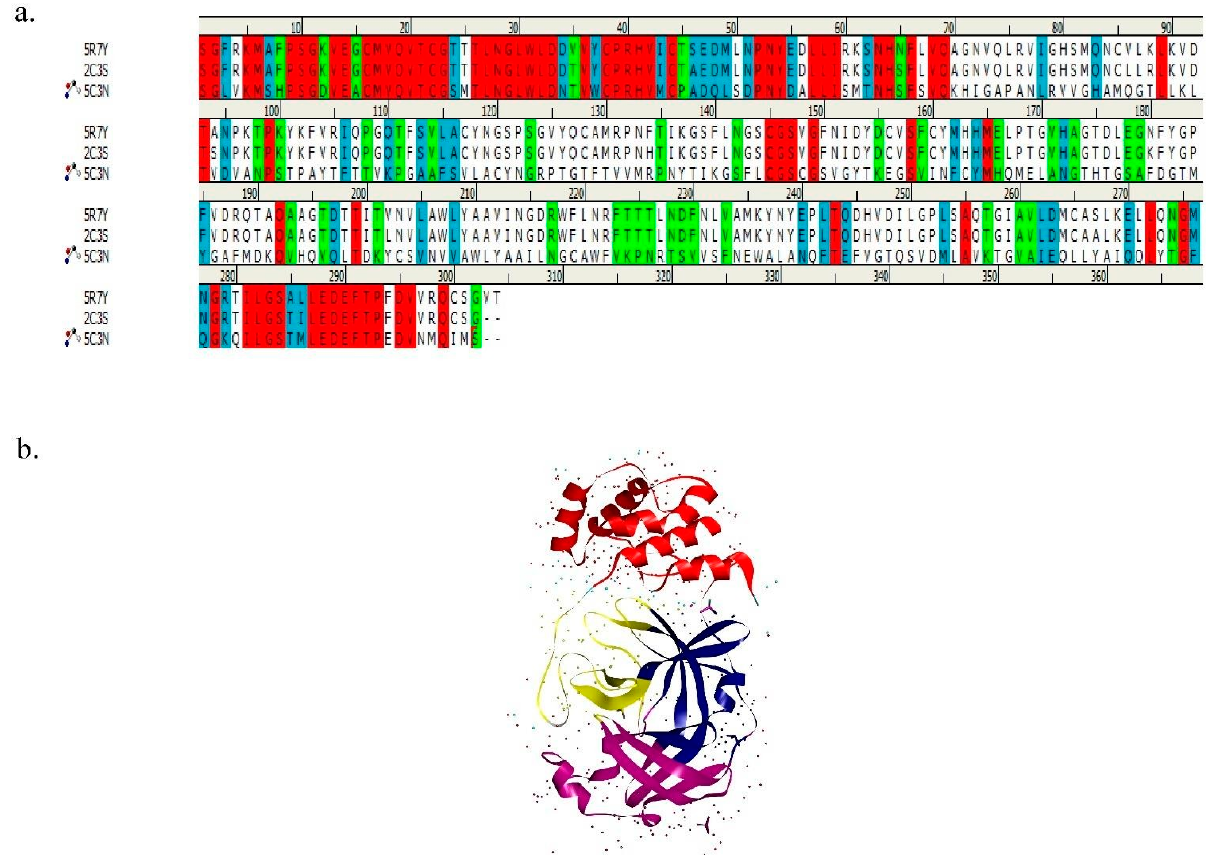
Figure 1. Sequence comparison matrix of COVID-19 proteins. ( a ) Sequence comparison between SARS-CoV-2 (PDB ID: 5R7Y), SARS-CoV (PDB ID: 2C3S), and MERS-CoV (PDB ID: 5C3N). ( b ) Primary structure of SARS-CoV-2 M pro (PDB ID: 5R7Y). Table 1. Sequence comparison matrix of SARS-CoV-2 (PDB ID: 5R7Y), SARS-CoV (PDB ID: 2C3S), and MERS-CoV (PDB ID: 5C3N). Identity matrix is expressed as a percentage.